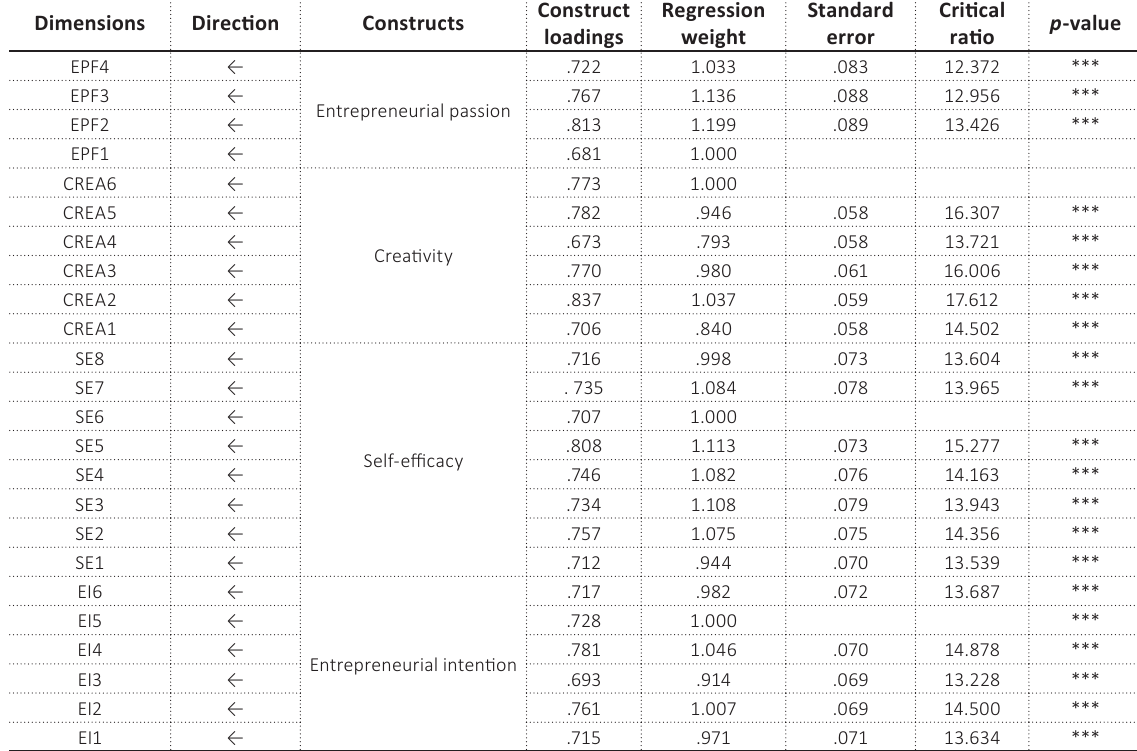
Table 2. Regression weights Dimensions